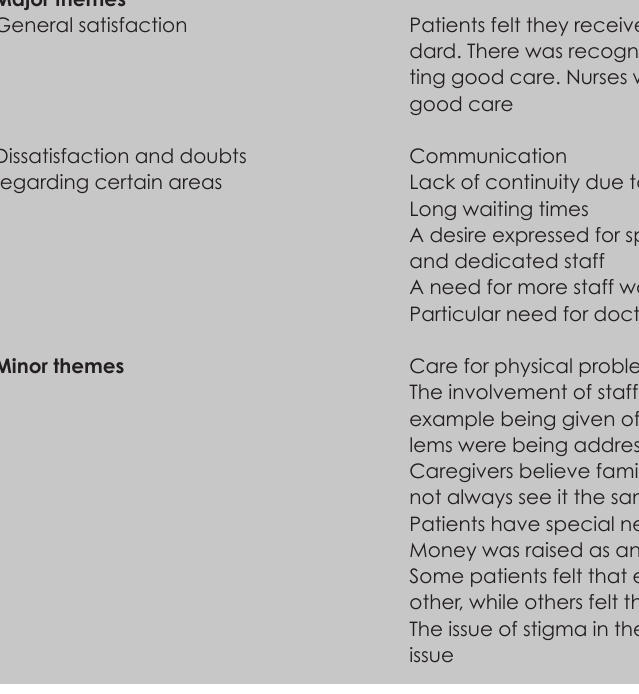
Table I. Major and minor themes from patients and their caregivers Major themes